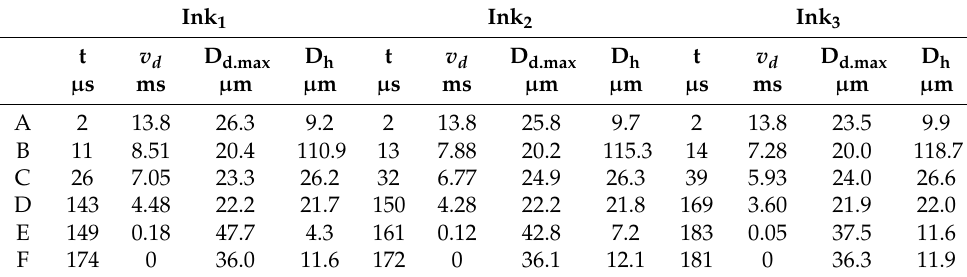
Table 2. Parameters of the considered inks at different points in time. Ink 1 Ink 2